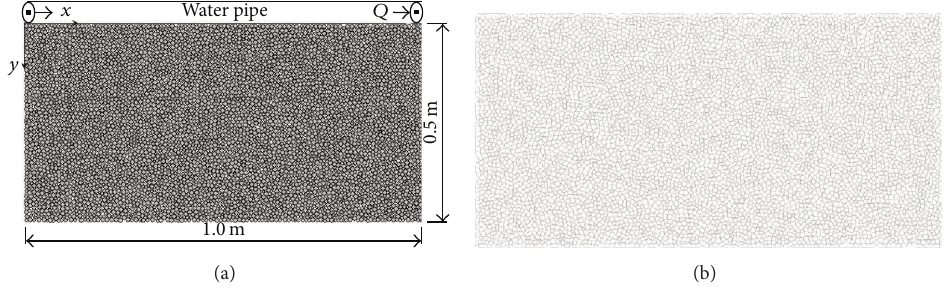
Figure 4: Particle model of a concrete slab: (a) position of water pipe and (b) parallel bonds network.